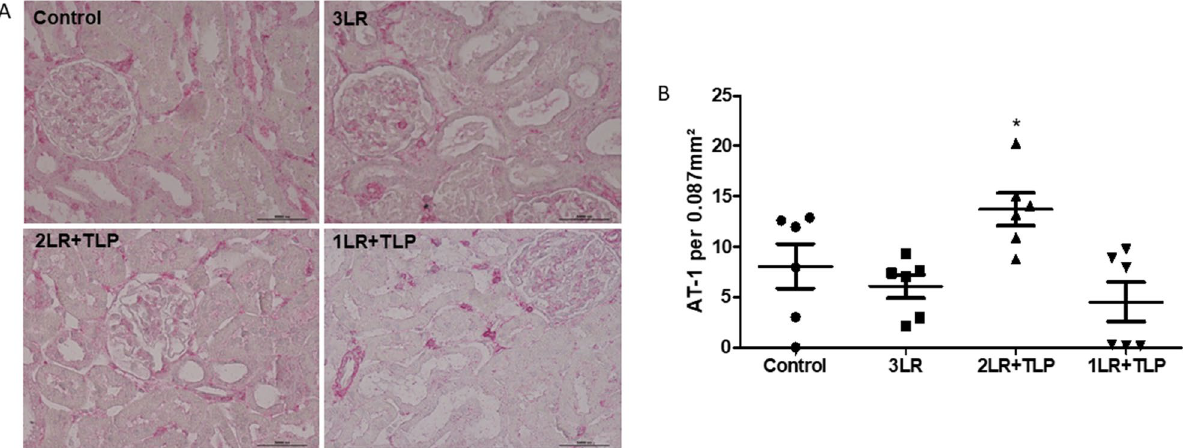
Figure 10. Immunohistochemical analysis of angiotensin II type 1 receptor (AT-1R) expression in rat kidney tissue. Immunostaining [violet, in ( A )] for AT-1R in kidney cortex samples from control, 3LR, 2LR + TLP, and 1LR + TLP group rats. Magnification, × 400. ( B ) Bar graph of AT-1R expression. * P < 0.05 vs. control, 3LR and 1LR + TLP; Control, no intervention; 3LR, induction of hemorrhagic shock, followed by infusion of lactated Ringer’s at 3 times the volume of the blood withdrawn; 2LR + TLP, induction of hemorrhagic shock, followed by infusion of lactated Ringer’s at 2 times the volume of the blood withdrawn, together with intravenous injection of terlipressin at 10 µg/100 g body weight; 1LR + TLP, induction of hemorrhagic shock, followed by infusion of lactated Ringer’s at a volume equal to that of the blood withdrawn, together with intravenous injection of terlipressin at 10 µg/100 g body